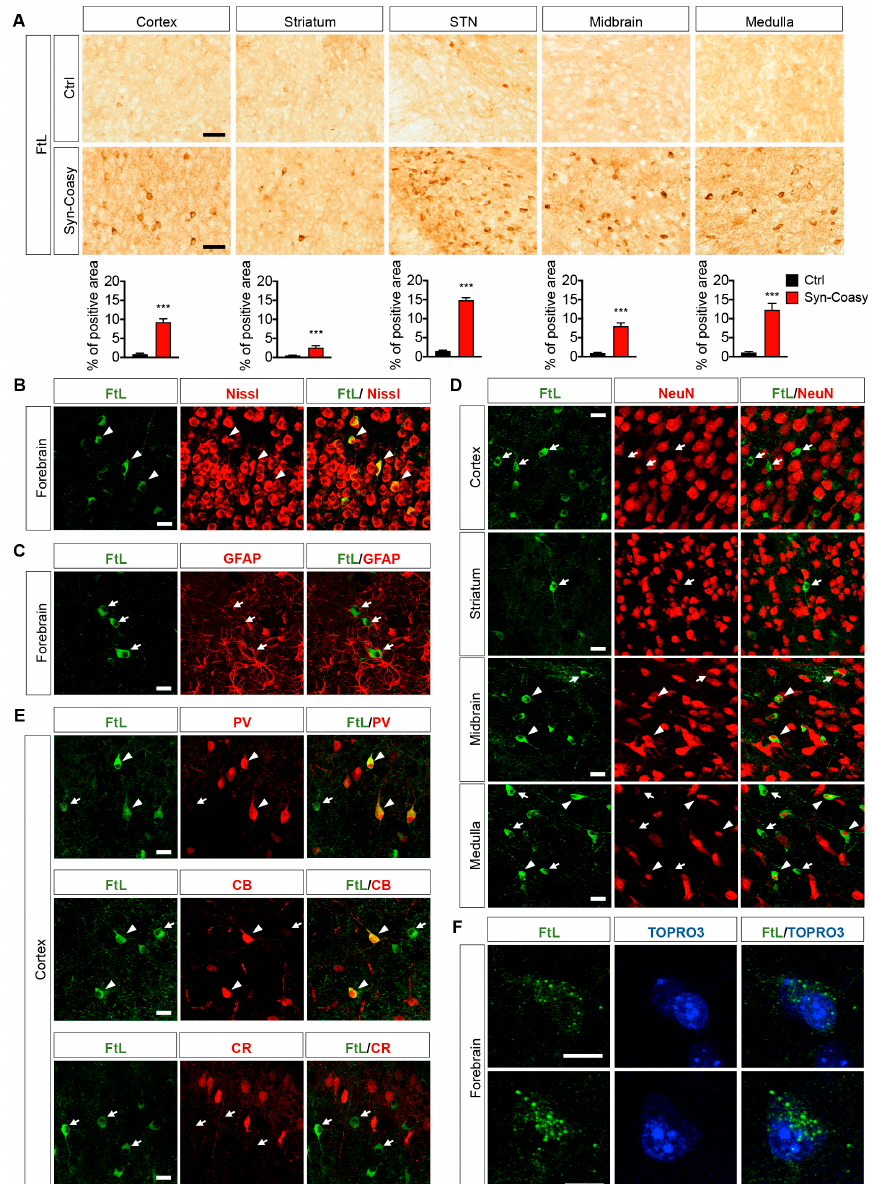
Figure 5. L-chain ferritin accumulation in sections of the Syn-Coasy mouse brain. ( A ) Immunohistochemical analysis of brains of 12–14-day-old animals showing FtL-positive cells accumulation in the cortex, striatum, subthalamic nucleus (STN), midbrain, and medulla of Syn-Coasy mice (bottom panels; n = 6) compared to control littermates (top panels; n = 6). Bar charts showing quantification of the percentage of the area occupied by FtL-positive staining are reported as mean ± SD. *** p < 0.001 (Student’s t-test). ( B ) Representative confocal immunofluorescence on the Syn-Coasy mice forebrain performed with an FtL antibody (green) and neuronal Nissl staining (neurotrace, red). Arrowheads indicate co-localization. ( C ) Double staining of FtL (green) and GFAP (red) in the Syn-Coasy forebrain. Arrows indicate an absence of co-localization. ( D ) Co-localization (arrowheads) or absence of co-localization (arrows) of FtL (green) and NeuN (red) in the Syn-Coasy cortex, striatum, midbrain, and medulla. ( E ) Presence (arrowheads) or absence (arrows) of co-localization of FtL (green) and PV, CB, or CR (red) in Syn-Coasy cortical tissue. ( F ) Detail of a Syn-Coasy forebrain co-labeled with FtL (green) and nuclear TOPRO3 (blue) showing granular ferritin accumulation. Scale bars are 100 µ m ( A ), 20 µ m ( B – E ), and 10 µ m ( F